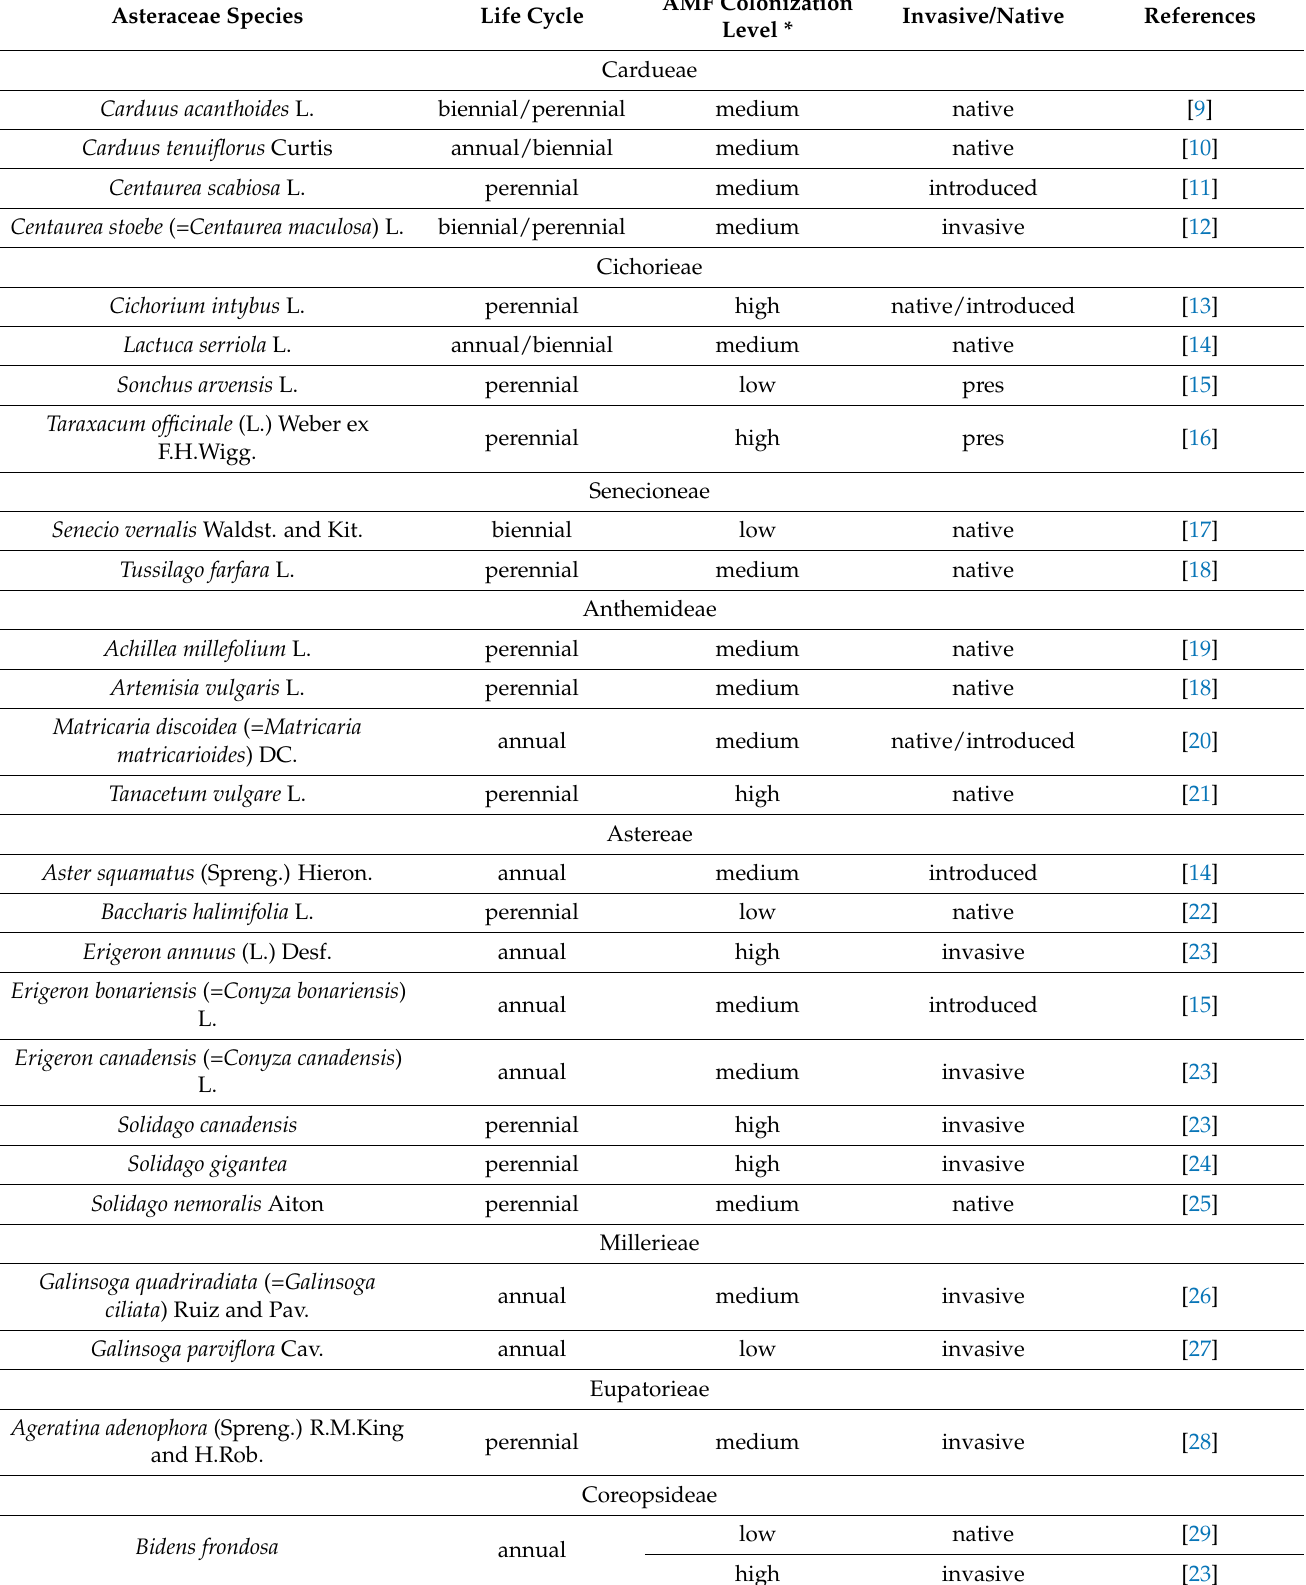
Table 1. AMF colonization level of different Asteraceae